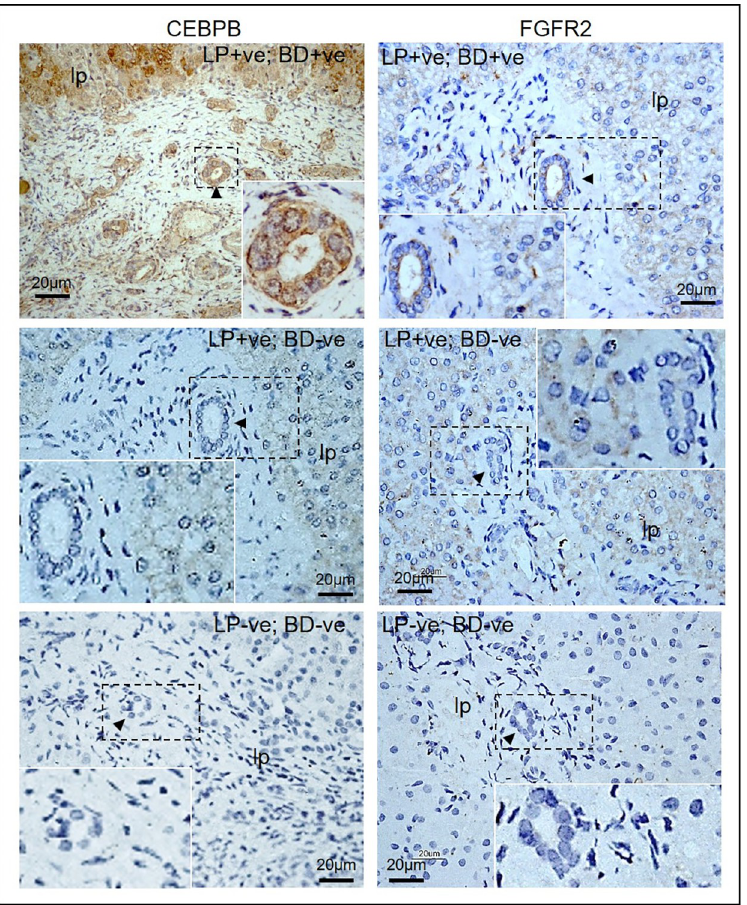
Fig 3. Immuno-histochemistry for FGFR2 and CEBPB in CC livers. CEBPB and FGFR2 immuno-reactivity (brown) was localized to the bile duct (arrowhead) or liver parenchyma (lp). Regions highlighted were enlarged and shown as